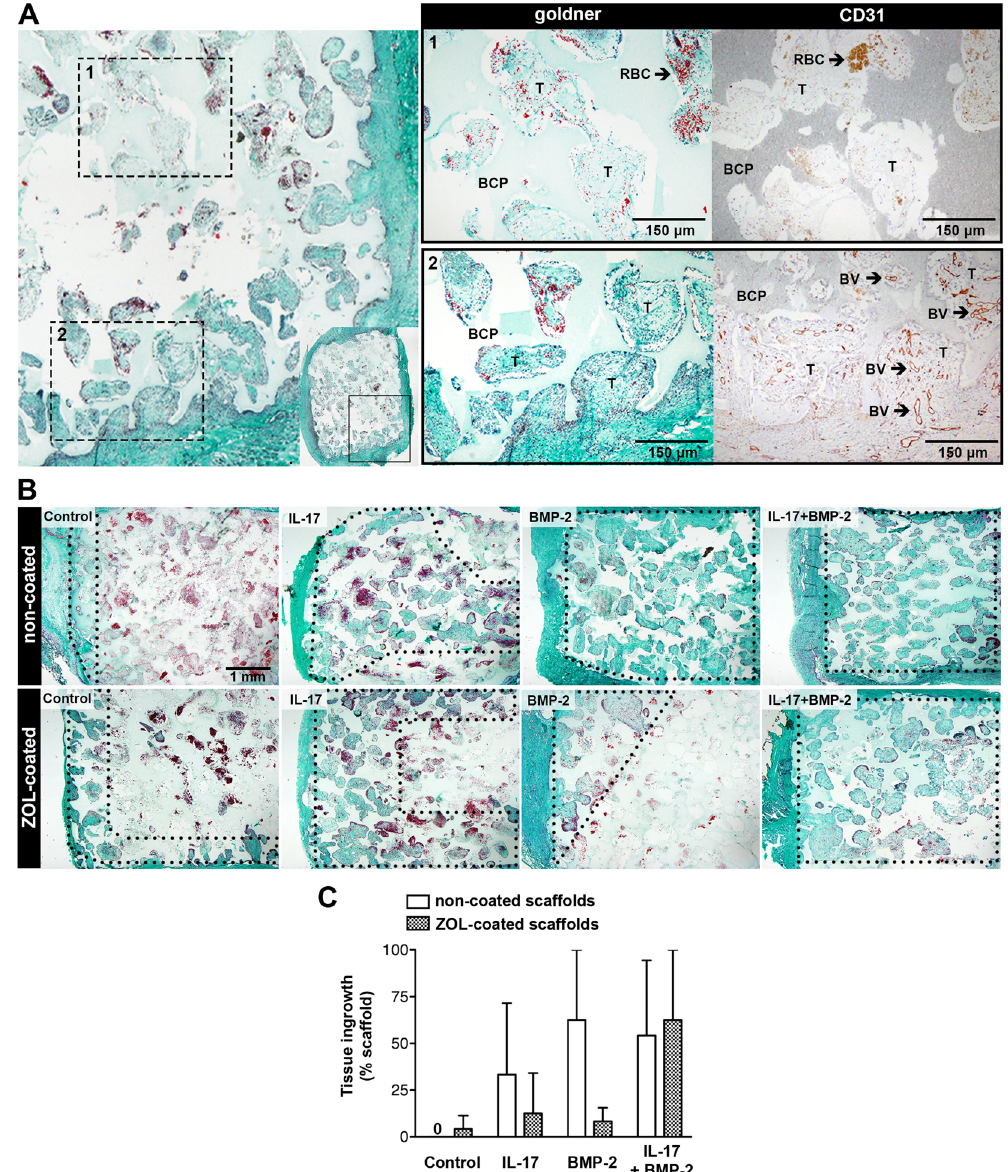
Figure 4. Connective tissue ingrowth in the 10-day study. ( A ) Goldner’s trichrome staining was indicative of collagen in connective tissue (in green); note differences in collagen between the periphery and central regions in a BMP-2-loaded construct without ZOL. CD31-positive blood vessels (BV, in brown) were only found in regions where connective tissue (T) had formed. ( B ) Goldner’s trichrome staining showing differences in connective tissue formation between groups. A region of interest is shown which covers half of the construct’s total area from the periphery (left) to the center (right). The areas within the dotted lines indicate regions of vascularized connective tissue formation. All images are representative for the group. ( C ) Quantification of vascularized connective tissue ingrowth, represented as the mean ± SD (n = 3). BCP, biphasic calcium phosphate; T, connective tissue; RBC, red blood